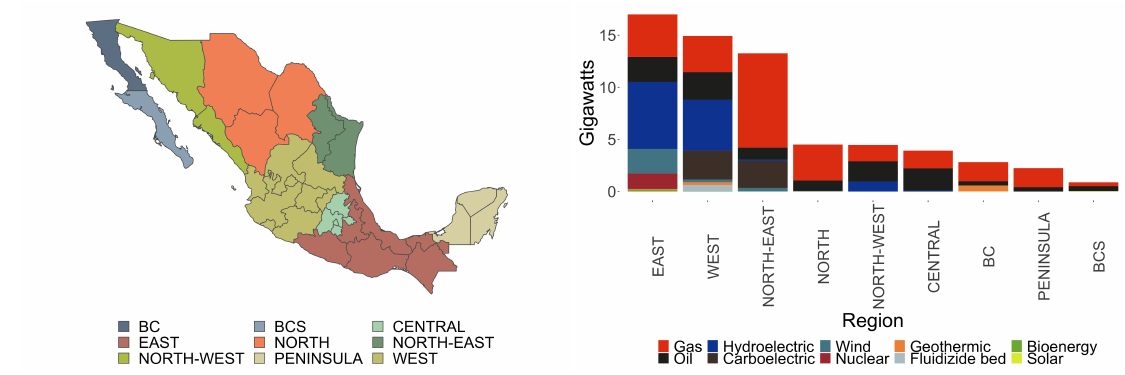
Figure 4. Modelled regions and Installed Capacity per